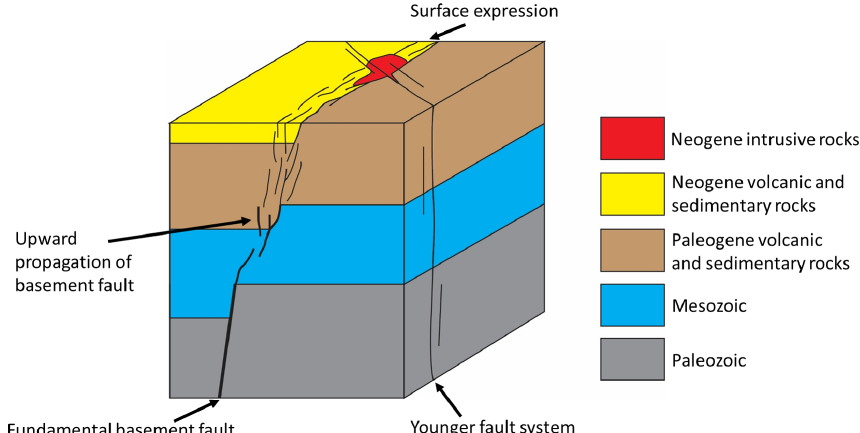
Figure 1. Schematic diagram showing how fundamental basement structures (FBSs) propagate upwards through younger rocks, being rep- resented at the current surface by a network of minor faults, often difficult to recognize in the field. The diagram also illustrates the common reactivation of this type of faults as basin-bounding faults under extensional conditions and the relationship between fundamental basement faults and the emplacement of intrusive complexes. A younger, cross-cutting fault system is also illustrated. Adapted from Fig. 7 of McCuaig and Hronsky (2014) and Fig. 9 of Piquer et al. (2019).